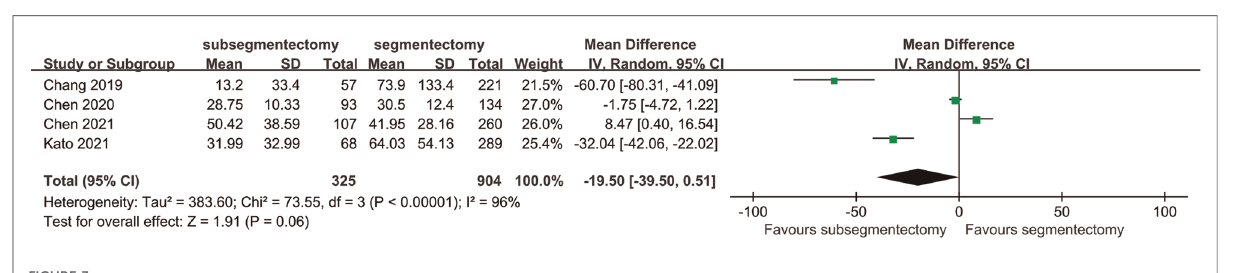
FIGURE 3 Forest plot: the blood loss of subsegmentectomy vs.